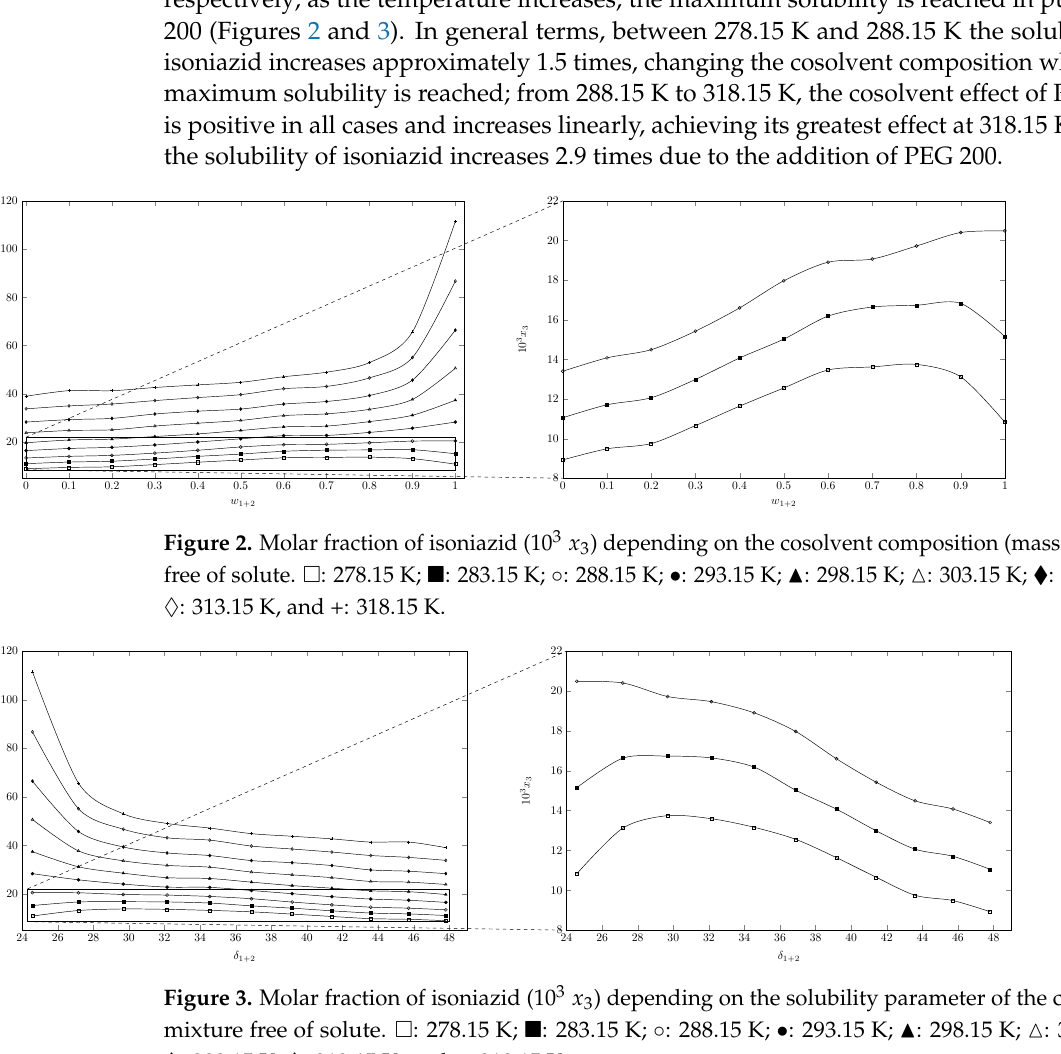
: 288.15 K; : 293.15 K; (cid:78) : 298.15 K; (cid:77) : 303.15 K; ◦ •